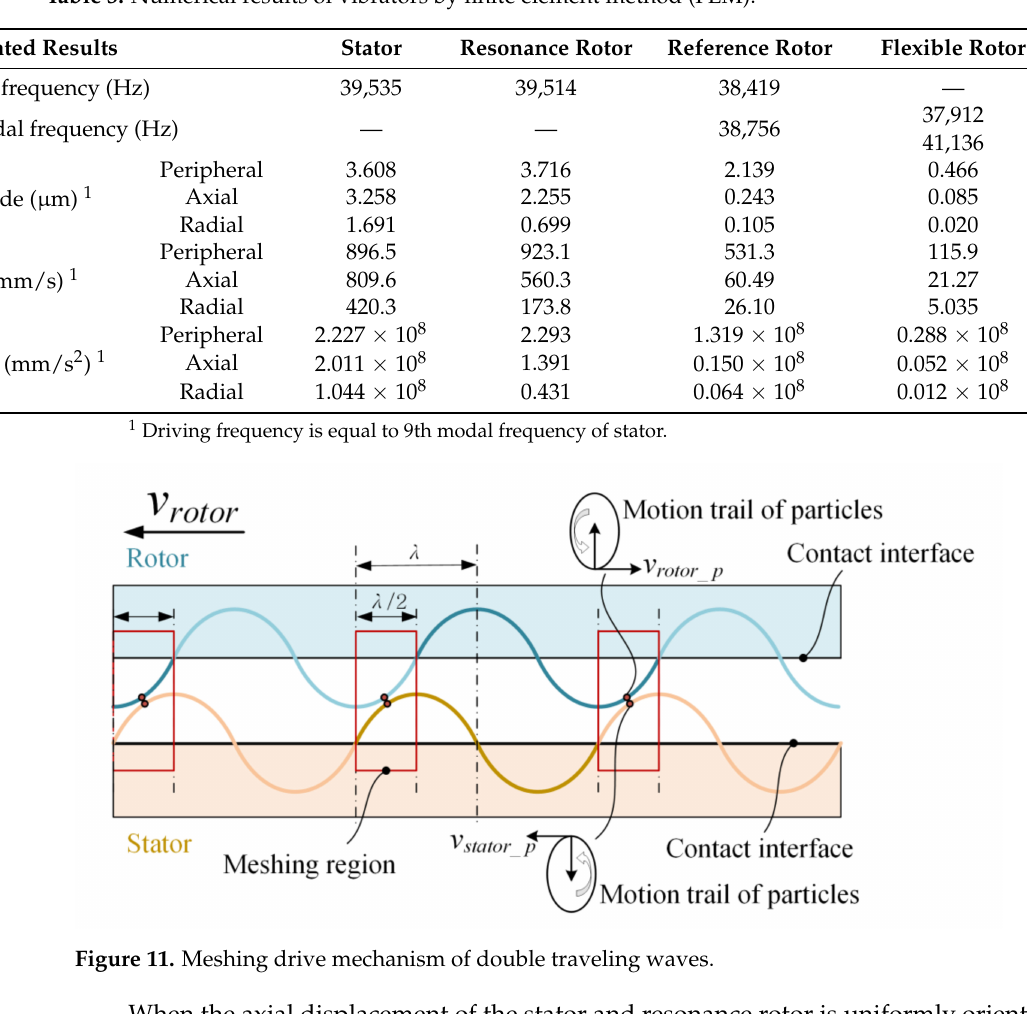
Table 3. Numerical results of vibrators by finite element method (FEM).